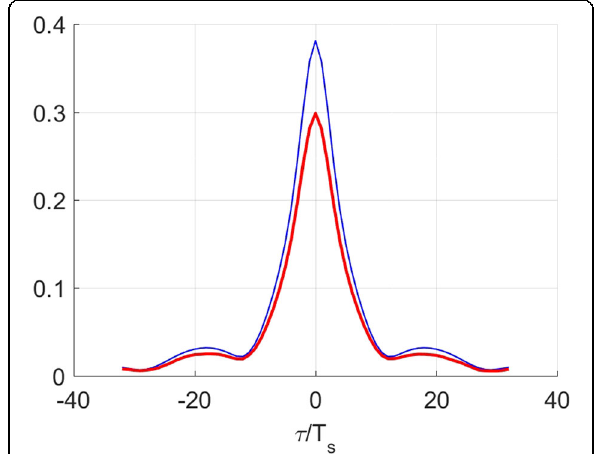
Fig. 8 Case A: magnitude of the cyclic correlogram of the de-warped data (thick red line) and of the data before warping (thin blue line) as functions of lag τ / T s at cycle frequency α =1/ T o (inexact warping frequencies, SNR ¼ 10